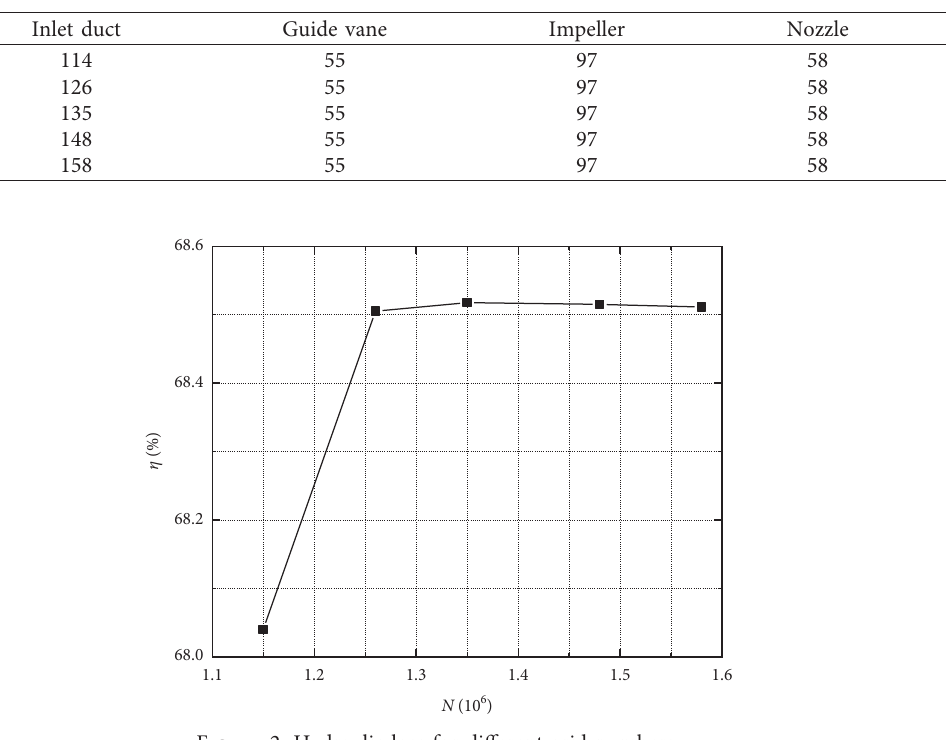
Figure 1: Computational domain. Table 1: Different grid numbers of inlet duct. Unit: ten thousand.